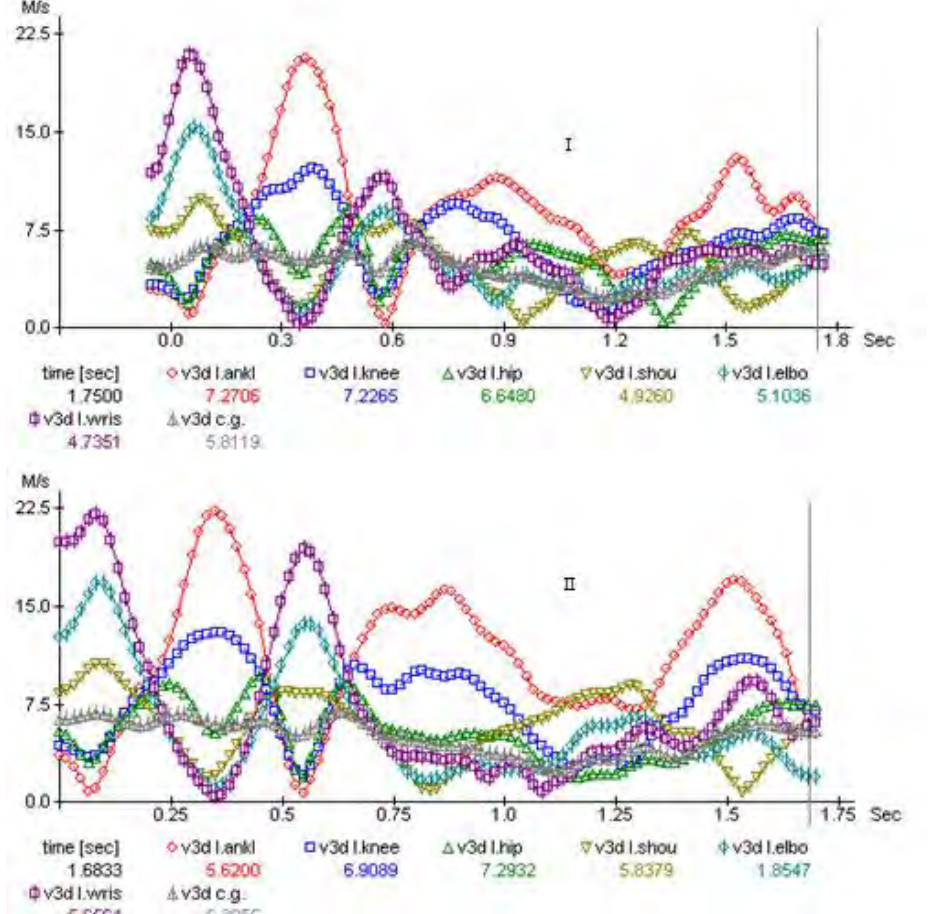
Fig. 8. Resultant speed values of ankle, knee, hip, shoulder, elbow and wrist joints, GMC in phase of final movements (FP) of grouped back double somersault after rondat (tested A, variant 1, upper section of figure, time 1. 750sec. ) and arched back double somersault after rondat – back turnover (tested B, lower section of figure, variant 2, time 1. 683